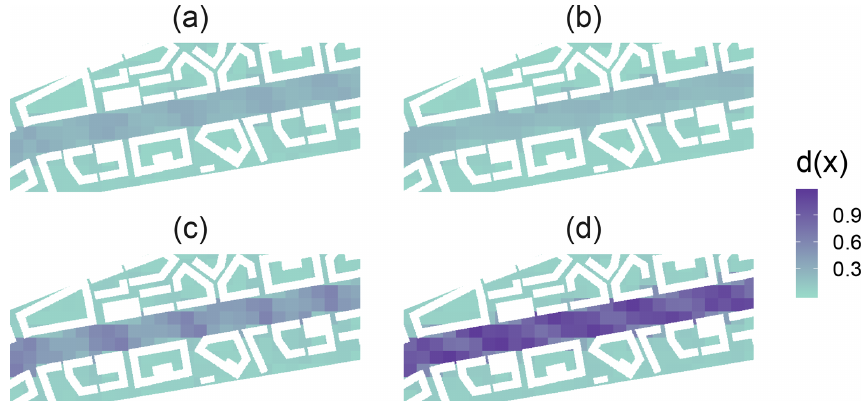
Figure 8. A map showing the concept drift indicator d (x) in a given segment of KA20 for (a) log-linear regression, (b) logarithmic support vector regression, (c) Gaussian process and (d) log-linear regression with all features used as the complete model. Notice how the last model has a high concept drift indicator on the